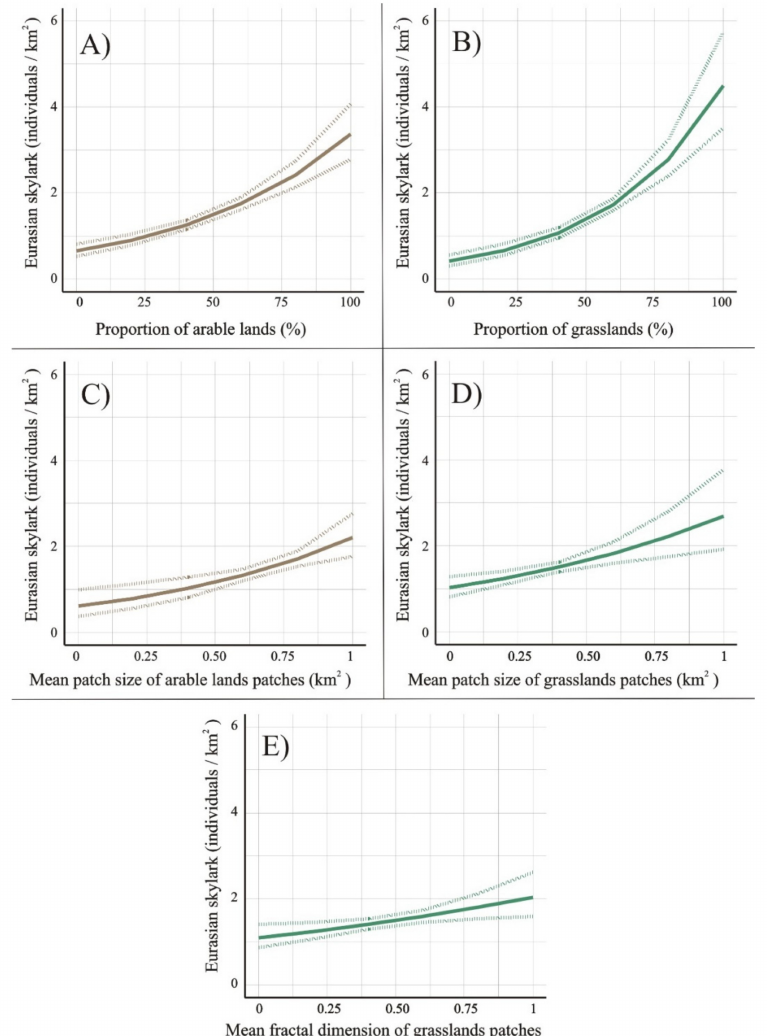
Figure 4. Predicted marginal effects between the skylark individuals / km2 proportions and land- scape metrics of arable and grasslands. The confidence intervals (95%) of the prediction are shown between the dotted lines. (( A ), Connection between the proportion of arable land and estimated population density of skylark, ( B ), Connection between the proportion of grassland and estimated population density of skylark, ( C ), Connection between the MPS of arable land and estimated popu- lation density of skylark, ( D ), Connection between the MPS of grassland and estimated population density of skylark, ( E ) Connection between the MFRACT of grassland and estimated population density of